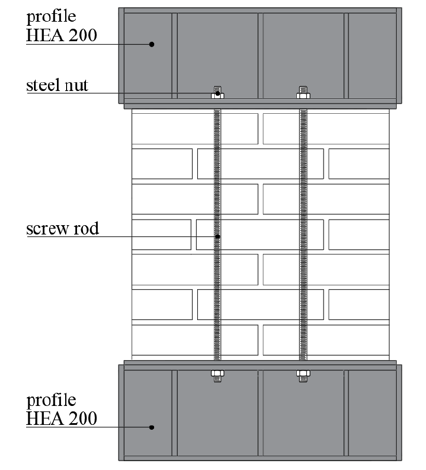
Figure 3. Steel contrast system.